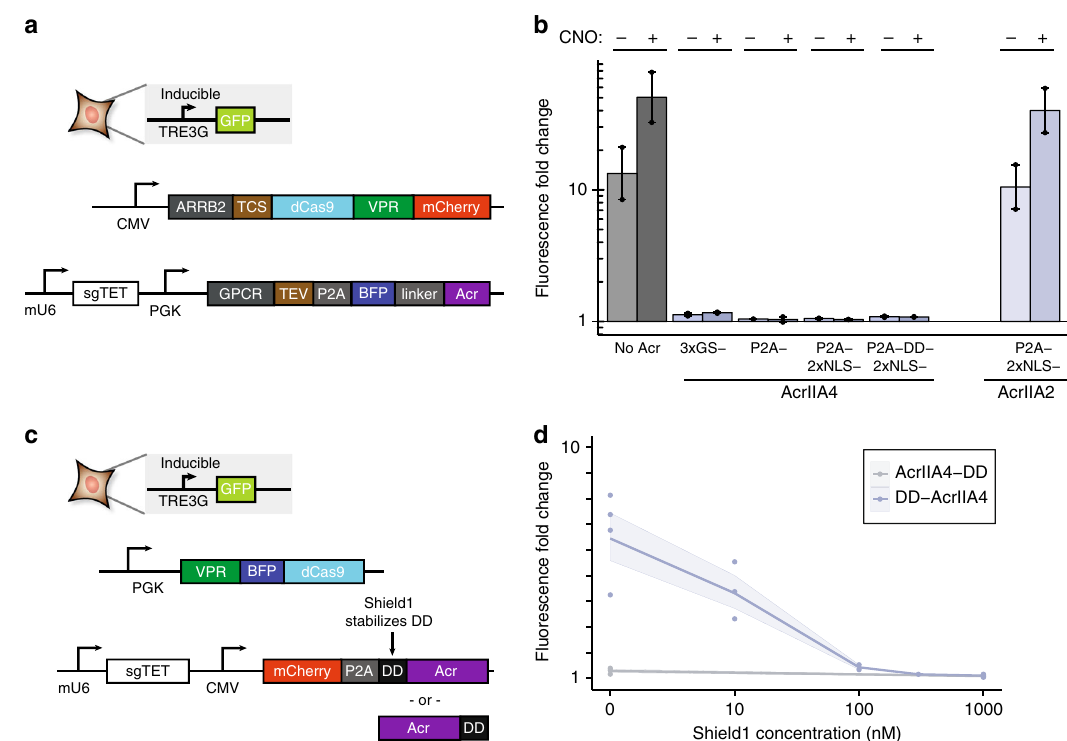
Fig. 4 Acr activity in inducible CRISPRa contexts. a Box diagram of GPCR activation experiment: a reporter cell line is transiently transfected with plasmids encoding sgRNA, synthetic GPCR with TEV protease and Acr, and β -arrestin-2 fused to dCas9-VPR via a TEV cleavage site (TCS). b Change in reporter fl uorescence with various Acr constructs in absence and presence of GPCR-activating ligand clozapine-N-oxide (CNO) for n = 2 experimental replicates. Source Data are provided as a Source Data fi le. c Diagram of Shield1-inducible control experiment: a reporter cell line is transiently transfected with CRISPRa VPR-dCas9 plasmid along with sgRNA plasmid containing fusions of AcrIIA4 to Shield1-stabilized destabilization domain (DD). d Inducible control of gene activation from DD-AcrIIA4 fusions as a function of stabilization reagent Shield1 for n = 3 experimental replicates ( n = 4 for DD-AcrIIA4 0 nM and 1000 nM conditions, n = 2 for 100 nM condition, and n = 1 for 300 nM condition). Source Data are provided as a Source Data fi le. Shaded region indicates±